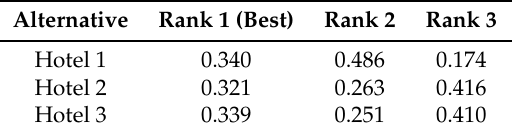
Table 8. Rank acceptability indices according to SMAA-O.